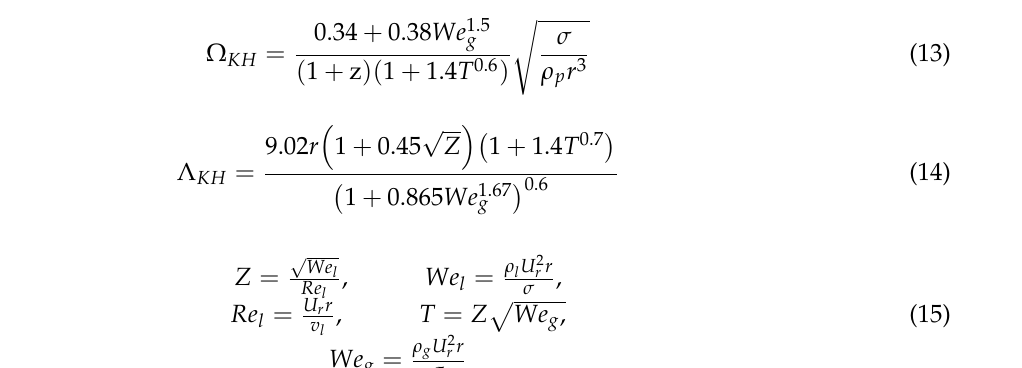
Figure 3. KHRT breakup model concept.